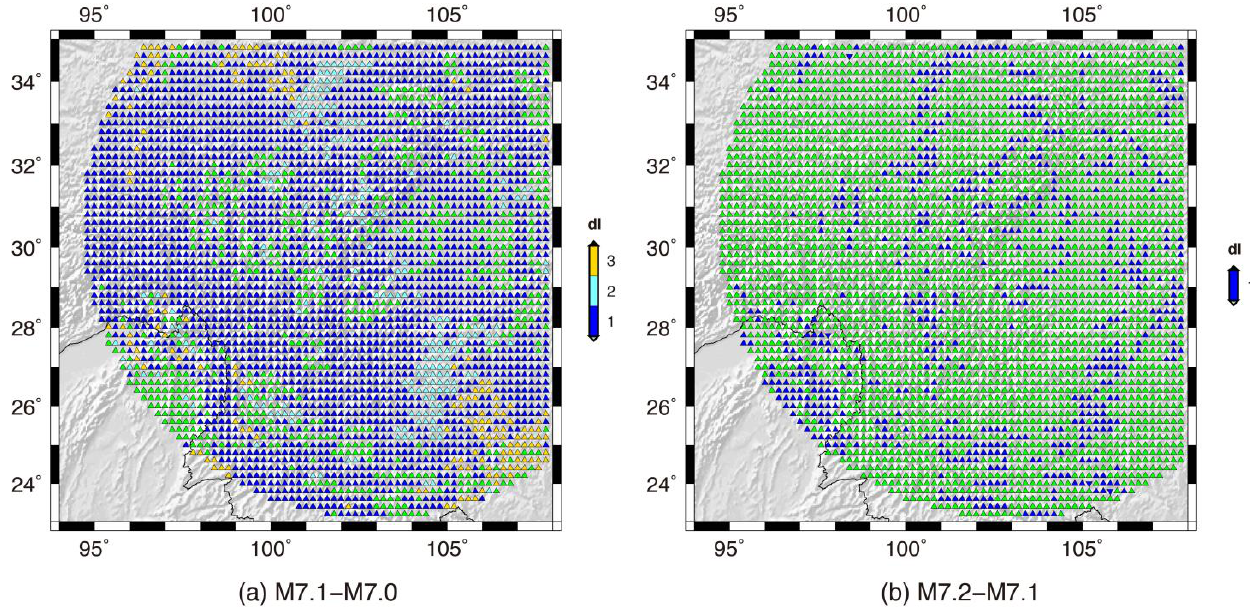
Figure 6. The differences of MMI values obtained from four scenarios with varying levels of magnitude (magnitude step is equal to 0.1), whereas the other focal parameters are fixed. Distribution of differences between ( a ) magnitude 7.1 and 7.0, and ( b ) magnitude 7.2 and 7.1 scenario computations. The green triangles indicate the different is zero.